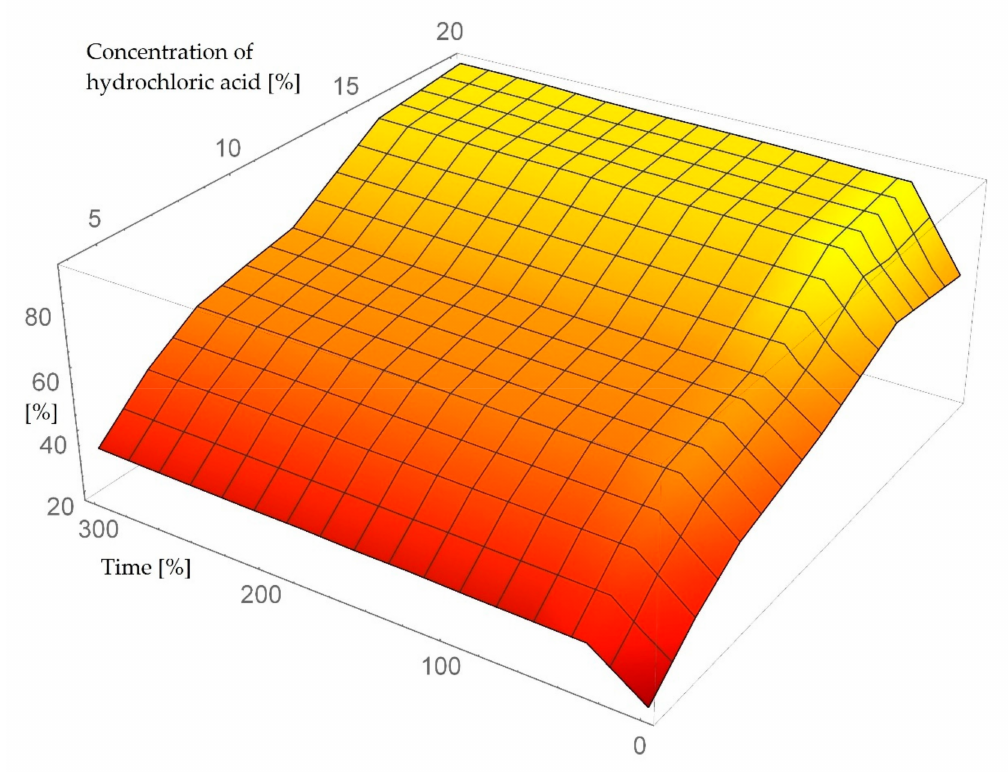
Figure 5. Extraction of copper from tailings. Efficiency of extraction vs. concentration of hydrochloric acid in solution and duration of activation